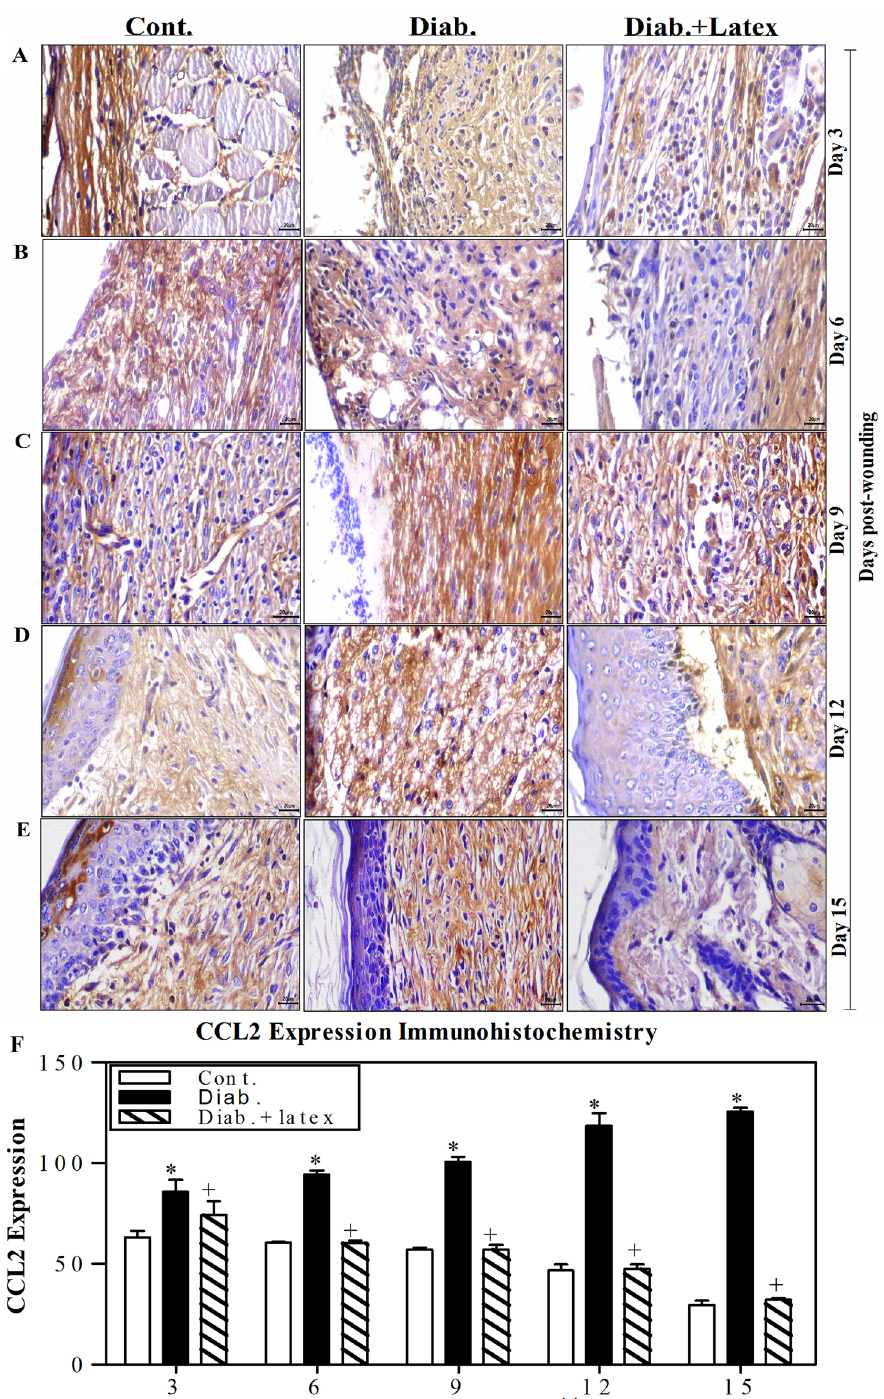
Figure 9. Topical application of fig latex restored the expression levels of CCL2 in wounded diabetic skin tissues. ( A , B , C , D and E ) show one representative experiment of CCL2 expression in the control mice, diabetic mice and diabetic mice treated with latex at Days 3, 6, 9, 12 and 15 post-wounding. ( F ) The CCL2 + cells were quantified in the three animal groups, and the accumulated results from three animals from each group are expressed as the mean percentage of CCL2 + cells ± SEM in control mice (open bars), diabetic mice (closed black bars) and diabetic mice treated with fig latex (hatched bars). * P < 0.05, diabetic versus control; and + P < 0.05, diabetic-treated with fig latex versus diabetic